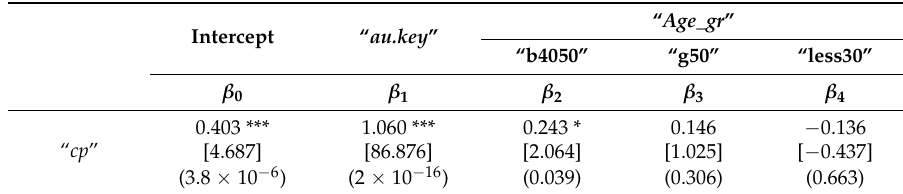
Table 4. Estimation results of “ cp ” against “ age_gr ” and “ au.key ”. Intercept “ au.key